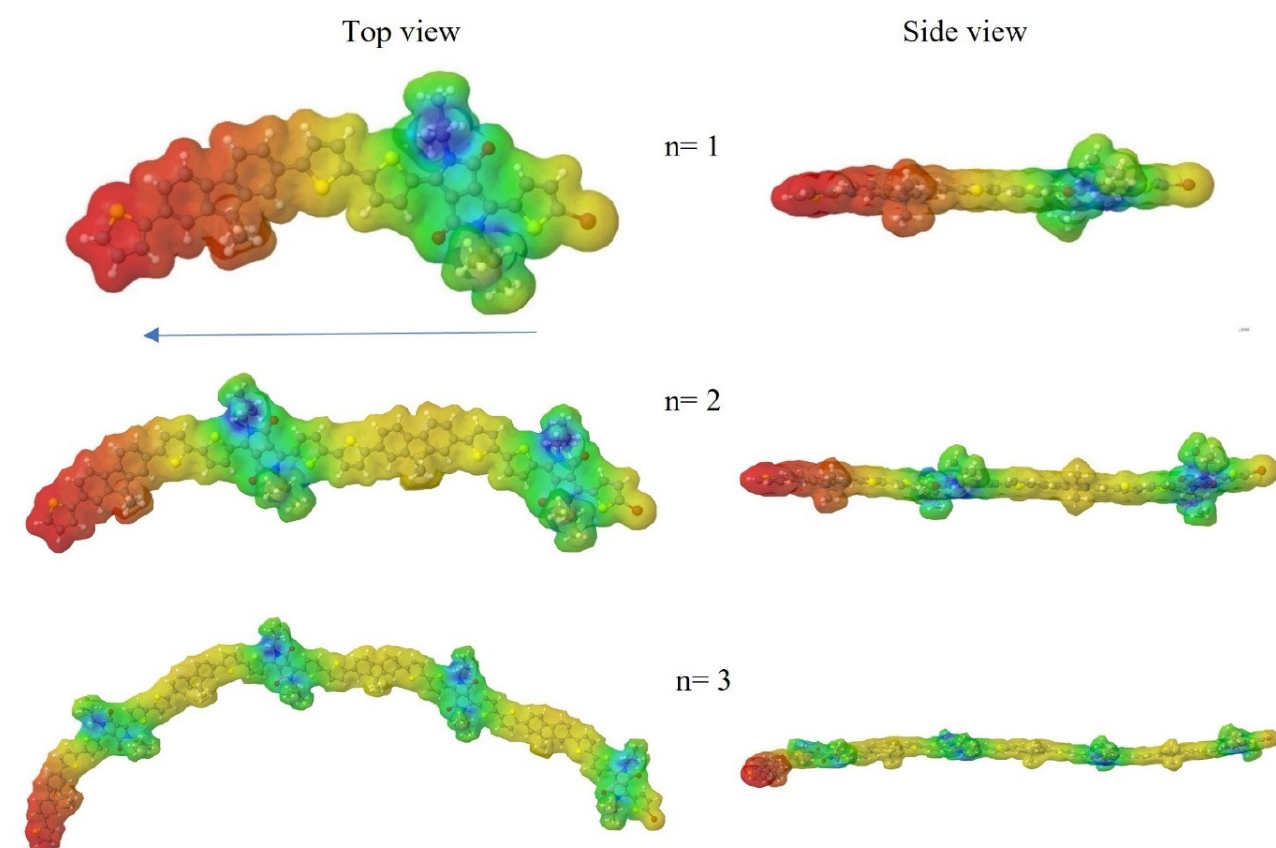
Figure 13. Calculated geometries of the ( PFDPP ) n polymers with n = 1, 2, and 4 units.